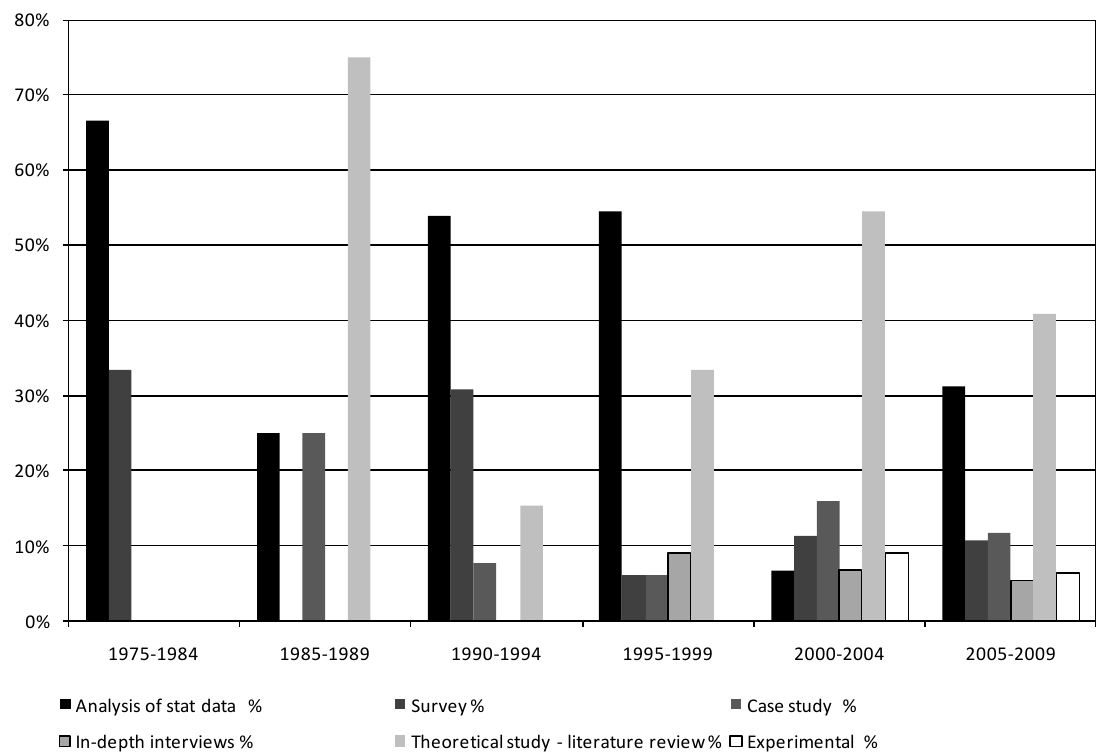
Figure 8: The appearance and frequency of research methodologies in the sampled academic SRI literature. Black bars indicate research approaches that tend to be qualitative while the grey bars indicate approaches that tend to be